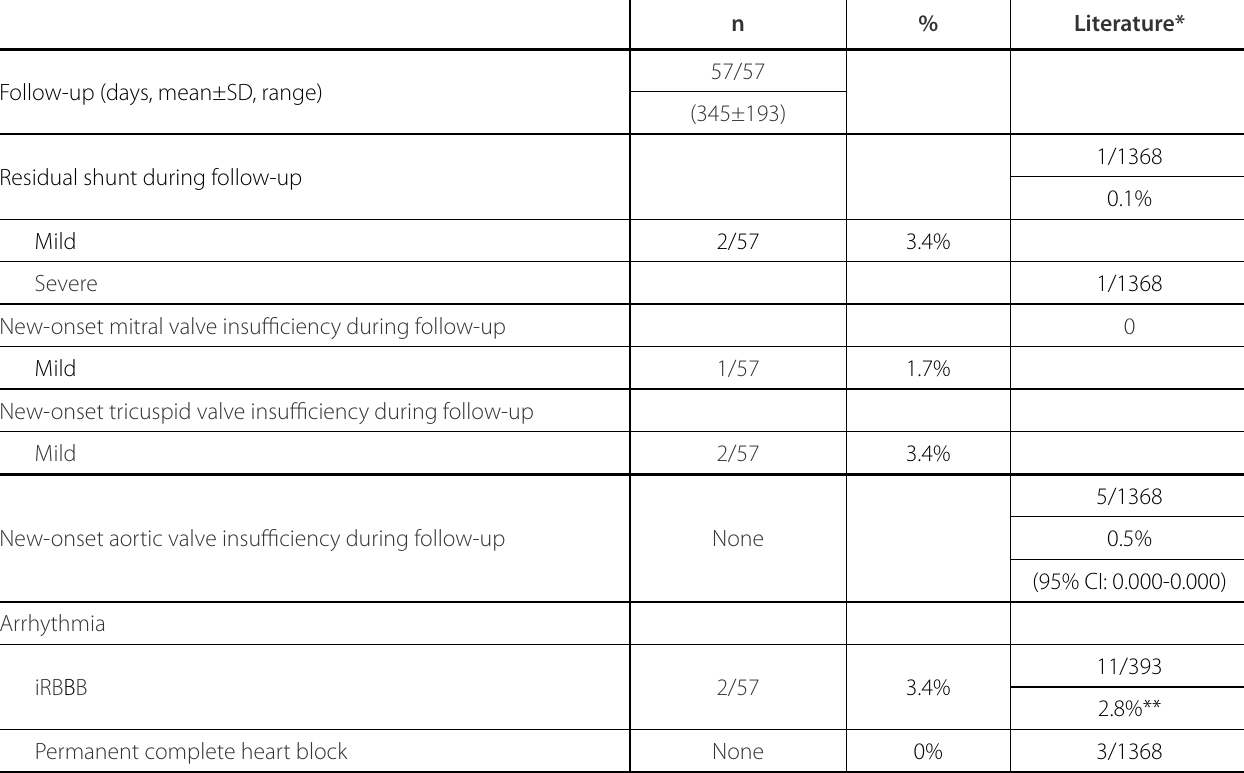
Table 3 . Follow-up